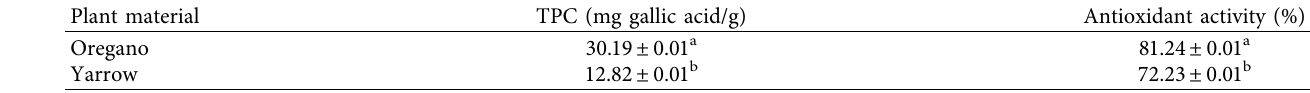
Table 1: TPC and antioxidant activities of plant